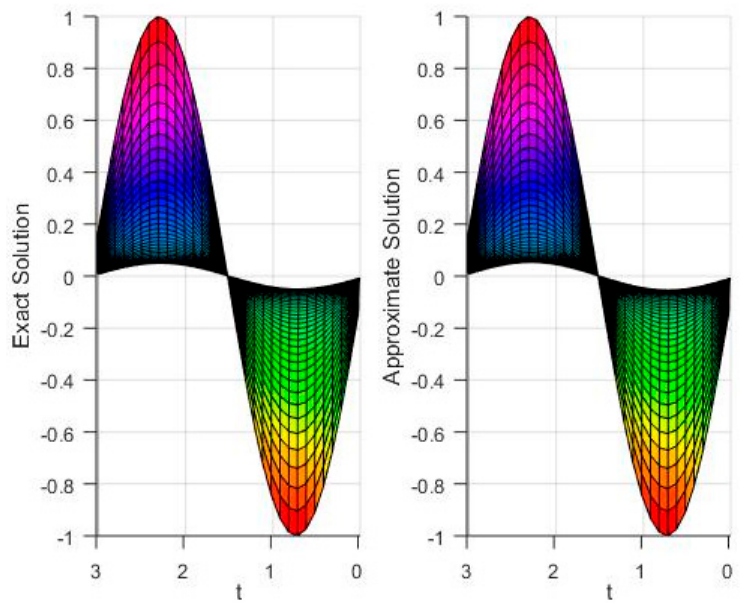
Figure 8. Comparison of the behavior of the exact and approximate solution for Test Problem 3.